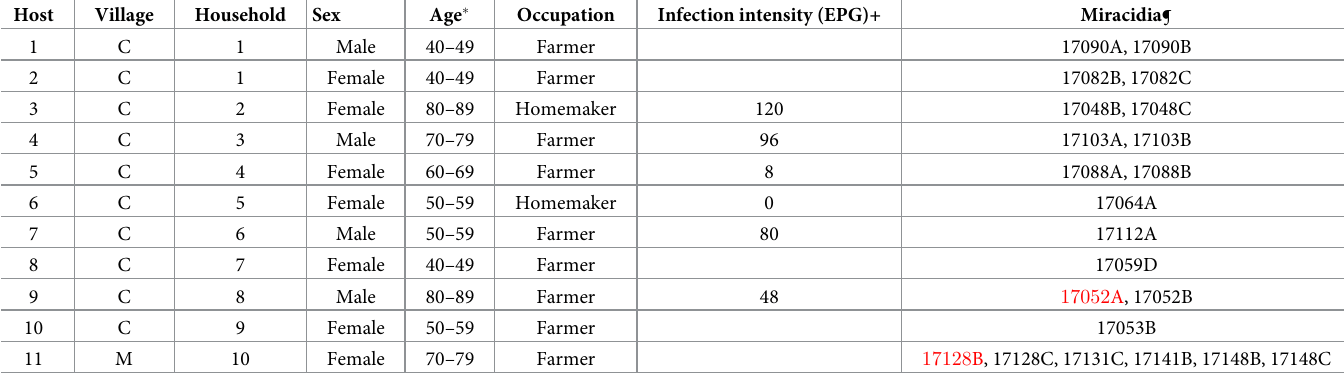
Table 1. Characteristics of the individuals from whom miracidia were